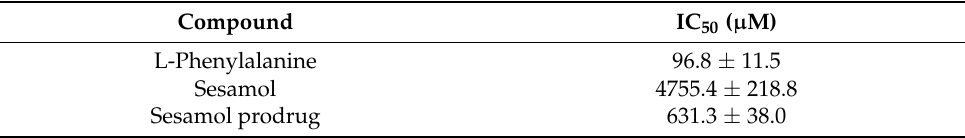
Figure 2. [ 14 C]-Leucine uptake inhibition testing of ( ◇ ) sesamol, ( ☐ ) sesamol prodrug, and (○) L - phenylalanine in hLAT1-transfected HEK293 cells . Table 1. Half-maximal inhibitory concentration (IC 50 ) of test compounds on [ 14 C] L-leucine in hLAT1 - HEK293 cells.